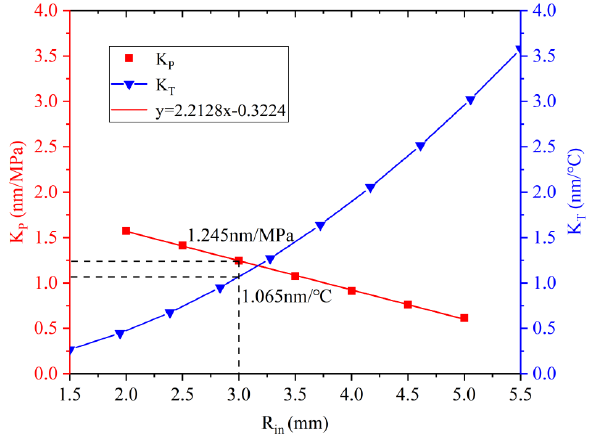
Figure 9. Relationship between temperature depth sensitivity and inner metal shell radius.